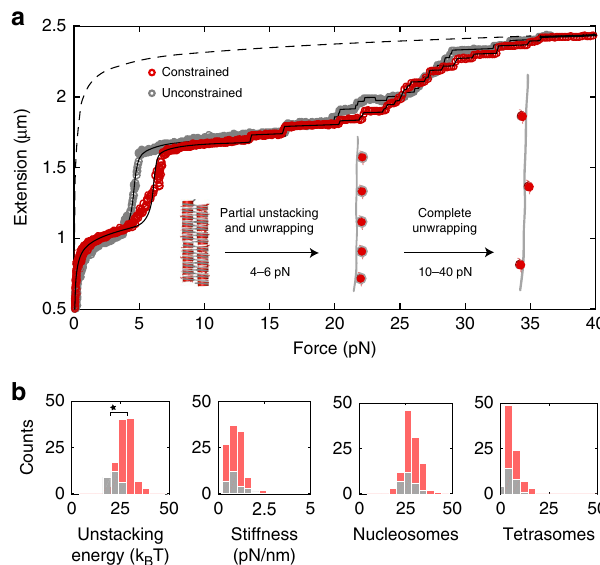
Fig. 2 The stacking of nucleosomes is stabilized by the presence of rotational constraint. a Force-extension (F – E) curves of 167-NRL chromatin fi bers assembled on a rotationally constrained (red) or unconstrained (grey) 601-DNA template. Both curves were fi t to the statistical mechanics model (black lines) derived in our earlier work 40 . From these fi ts, the number of nucleosomes N and the number of nucleosomes tetrasomes N in the fi bers were determined. These equaled 25 ± 1 tetrasomes and 1 ± 1, respectively, in both tethers. The F – E response for 7.0 kb DNA according to the WLC model is co-plotted (dashed line). Below 1 pN, the response of the tethers to force re fl ects the entropic elasticity of the DNA handles that fl ank the folded chromatin fi ber. Subsequently, in a linear regime between 1 and 4 pN, the stretching elasticity of the fi ber dominates the F – E curve. Beyond 4 pN, in the rotationally unconstrained tether, the unstacking transition is observed, which results in a gain in the extension of nearly 0.5 μ m due to the release of linker DNA between nucleosomes and (cid:4) 56 bp of unwrapped DNA per nucleosome. In the rotationally constrained tether, the unstacking transition occurs at a higher force of 6.5 pN. Further increase of force results in a gradual increase in the extension ( (cid:4) 10 bp per nucleosome) 40 and from (cid:4) 10 pN onwards, in a step-wise unwrapping of the remaining 80 bp of DNA from each octamer (or tetramer). Beyond 35 pN, the extension of the tether equals that of bare DNA, indicating complete unwrapping of DNA from the nucleosomes. The inset depicts the conformational changes of DNA and chromatin induced by the increasing force. b Distributions of parameters that result from quantitative analysis of rotationally constrained ( n = 112, red) and unconstrained ( n = 27, grey) 167-NRL fi bers with the statistical mechanics model 40 . The fi bers contain on average 27 ± 3 and 27 ± 4 (mean ± SD) assembled core particles (either nucleosomes or tetrasomes), respectively. The deduced stretching stiffnesses of 1.0 ± 0.5 (for rotationally constrained fi bers) and 0.9 ± 0.4 pN (cid:3) nm (cid:1) 1 (for rotationally unconstrained fi bers) are similar to those obtained in our previous work 36,40 . The mean unstacking energy of 27 ± 4 k T in rotationally constrained fi bers is signi fi cantly larger (Student t -test, B p -value = 0.05) than in unconstrained fi bers (21 ± 2 k T ). Source data are B provided as a Source Data fi